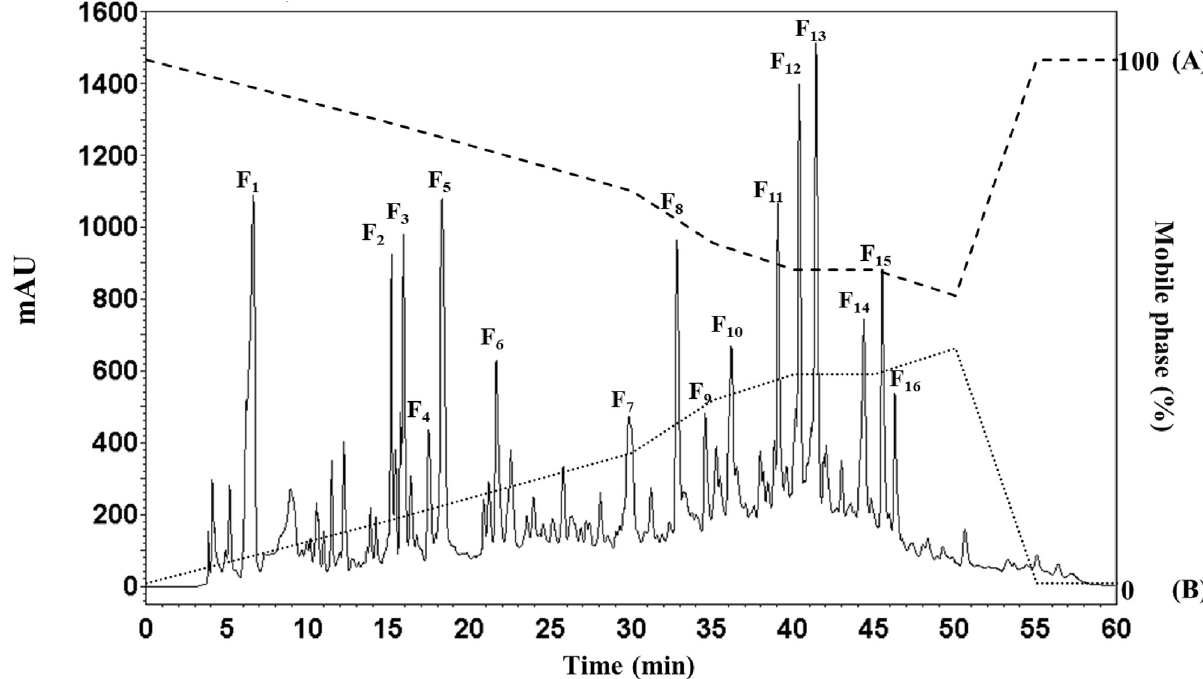
Fig 4. The RP-HPLC chromatogram of the molecular weight cut-off < 0.65 kDa fraction of the trypsin hydrolysate obtained from salmon bones.